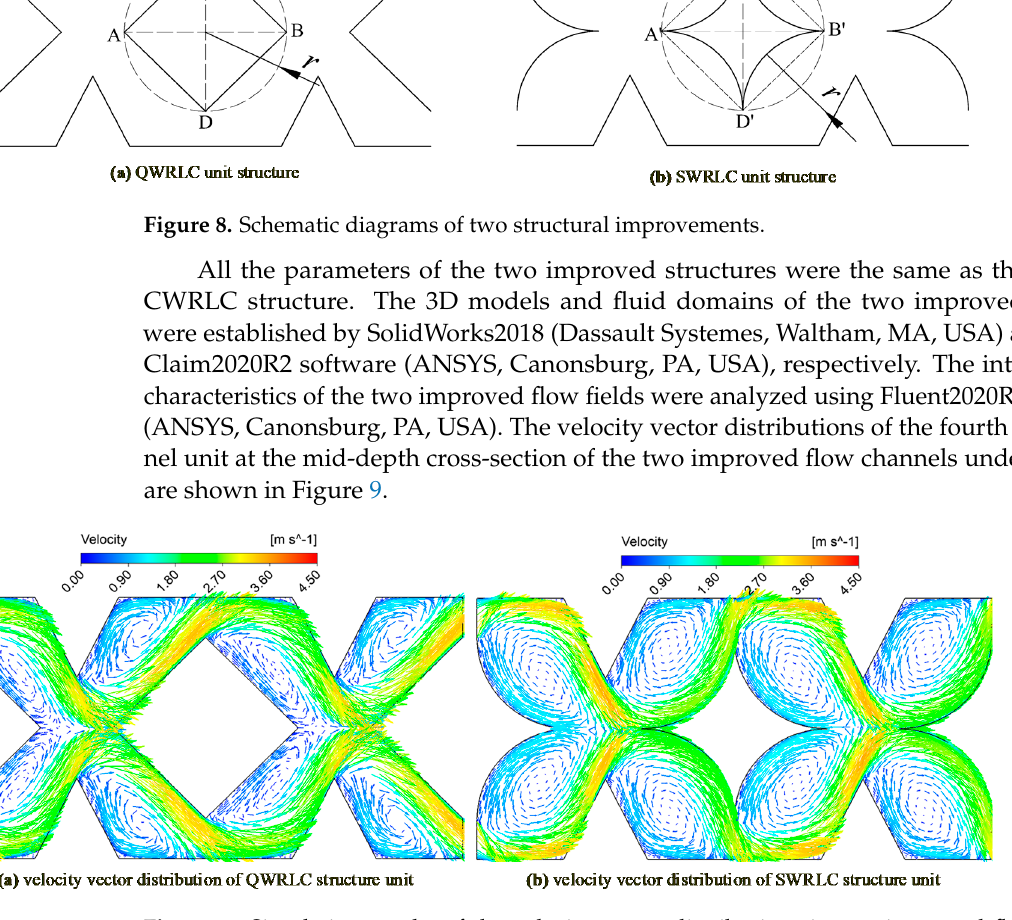
Figure 9. Simulation results of the velocity vector distributions in two improved flow channel structures under 100 KPa.